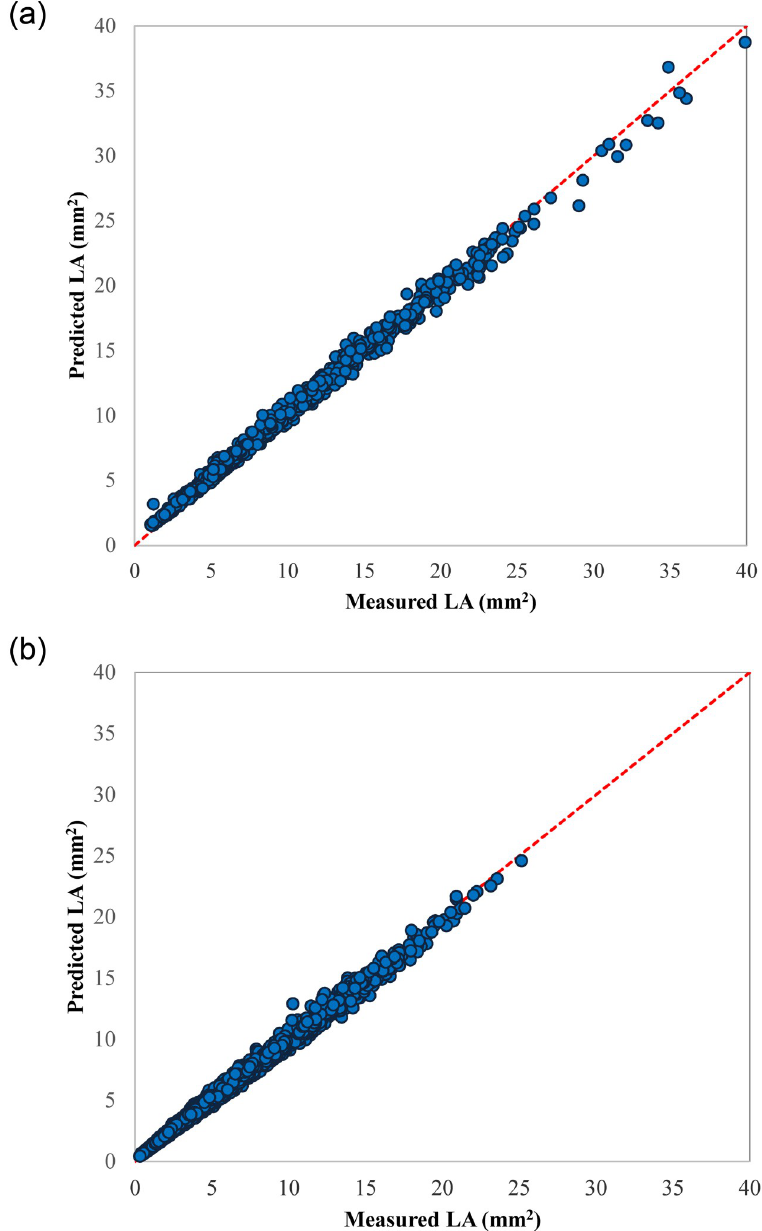
Fig 12. Scatter plots of estimated LA values by linear SVR model vs. the corresponding measured LA values, a) 2019 experiments, and d) 2021